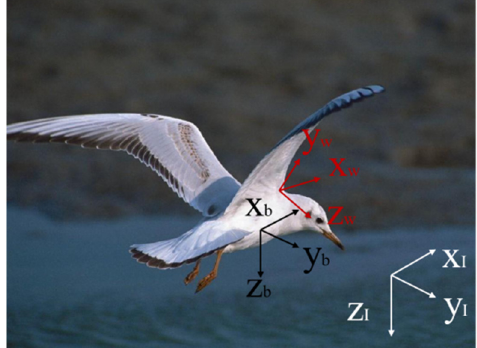
Figure 1. The coordinate system for seagulls.